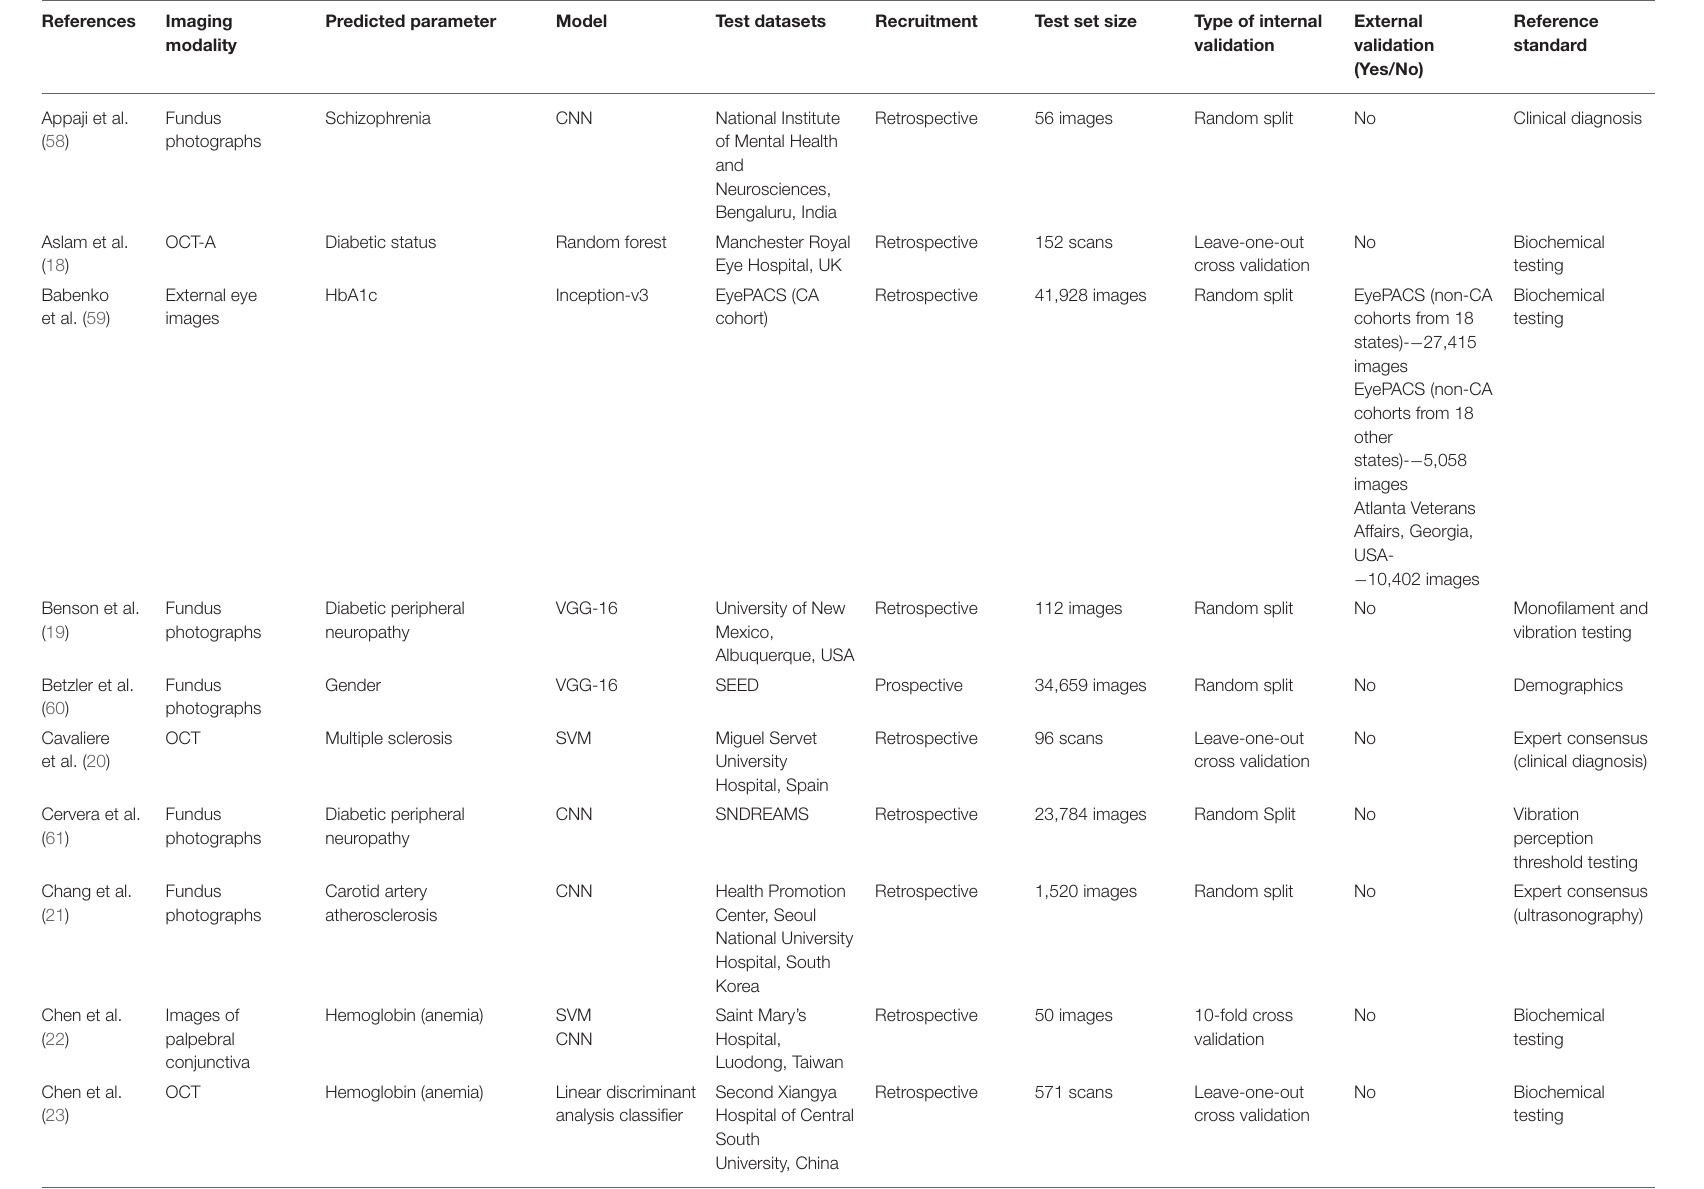
TABLE 1 | Summary of studies in current